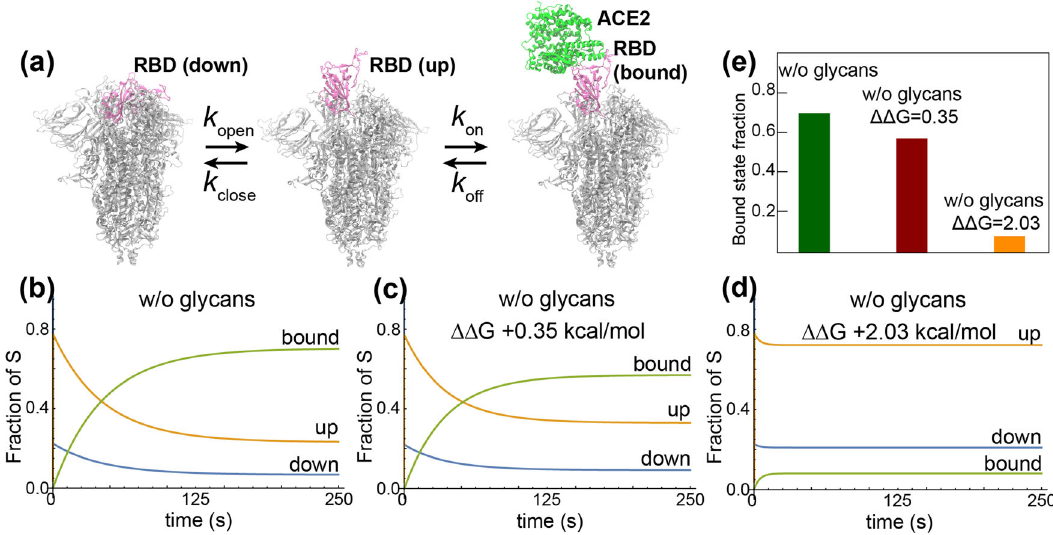
Fig. 3 Kinetics of S-protein opening and closing. a Transitions between RBD-down, up, and bound states are shown with their associated rates. b – d Fraction of S proteins in each state (up, down, and ACE2-bound) under different conditions, namely b with no glycans, c with no glycans and an assumed increase in the free energy of binding of RBD to ACE2 of 0.35 kcal/mol, and d with no glycans and an increase in binding free energy of 2.03 kcal/ mol. e Bound-state fraction at equilibrium for the three conditions in ( b – d